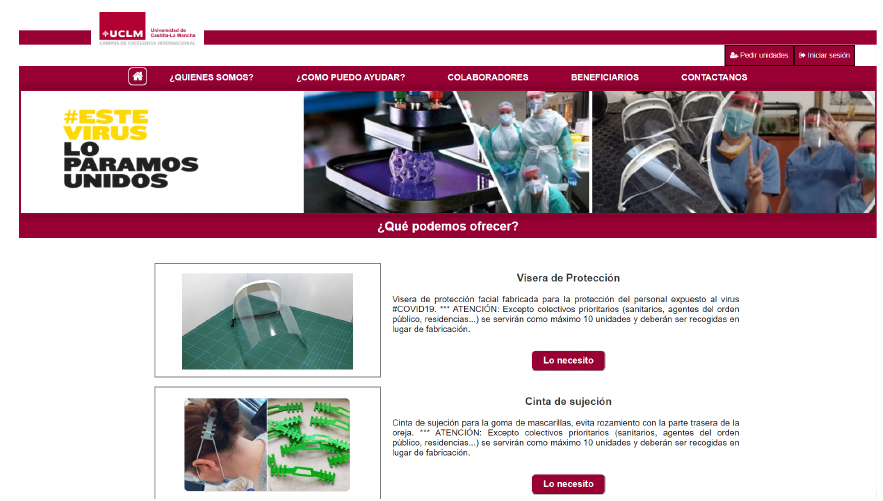
Figure 5. Home page displayed on the frontend of the web information system.